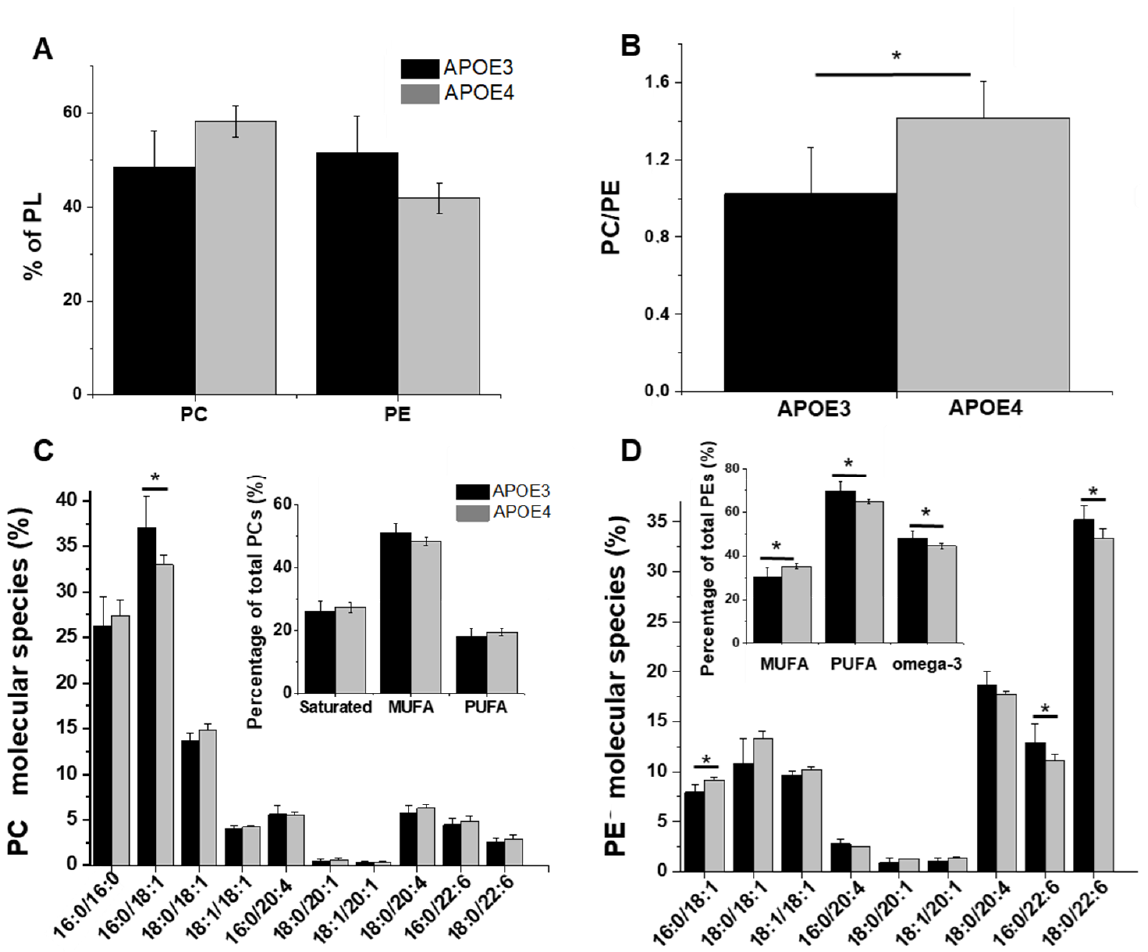
Figure 2. Distribution of the two major classes of phospholipids detected in APOE3 and APOE4 mice: ( A ) percentage of PC and PE in the brain of APOE3 and APOE4 mice; ( B ) the ratio PC/PE; ( C ) molecular species of PC and percentage of PC bearing saturated, monounsaturated (MUFAs) or polyunsaturated fatty acids (PUFAs); ( D ) molecular species of PE and percentage of PE bearing monounsaturated (MUFAs), polyunsaturated fatty acids (PUFAs) or omega-3 fatty acids. Statistics: one-way ANOVA with Ficher’s correction *: p <0.05.